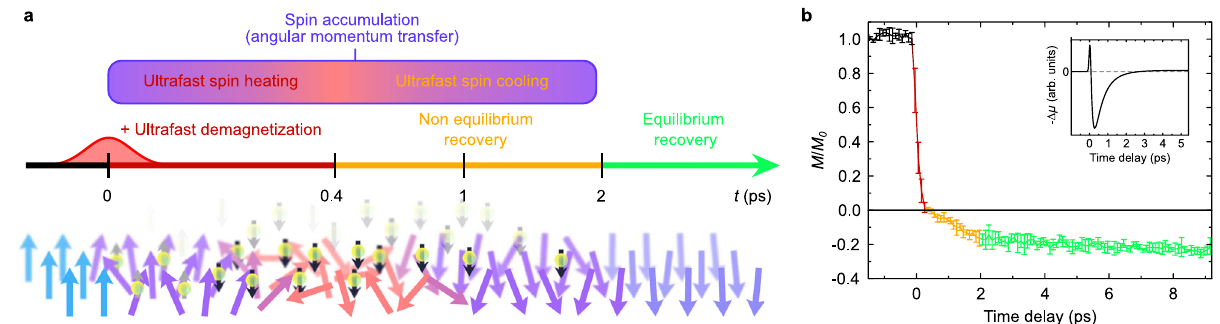
Fig. 2 | Mechanism and temporal evolution of magnetization reversal of the free [Co/Pt] layer in our collinear. a Schematic of the magnetization reversal process. Solid arrows represent the ferromagnet (atomic) spins, whilebullets with arrows represent the injected spin accumulation. The red-shaded Gaussian curve represents the 100fs (800nm) pump laser pulse. b Experimental results of the ultrafast magnetization reversal of the [Co/Pt] ferromagnetic multilayer (P